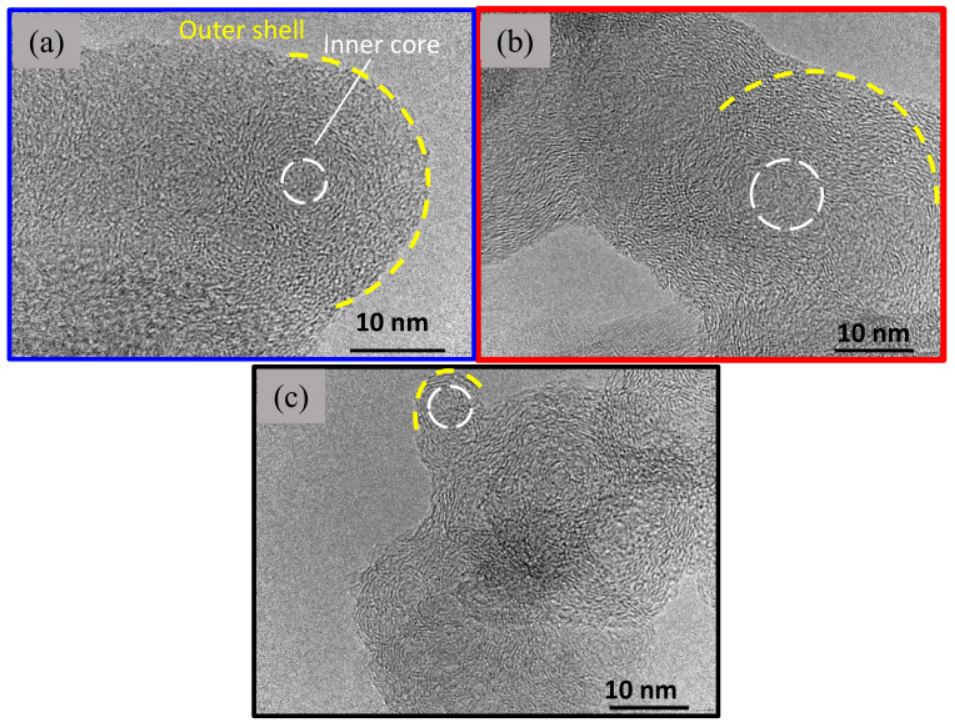
Figure 5. TEM images of primary particles ( a ) LabSoot, ( b ) Printex U and ( c ) BenchSoot samples.